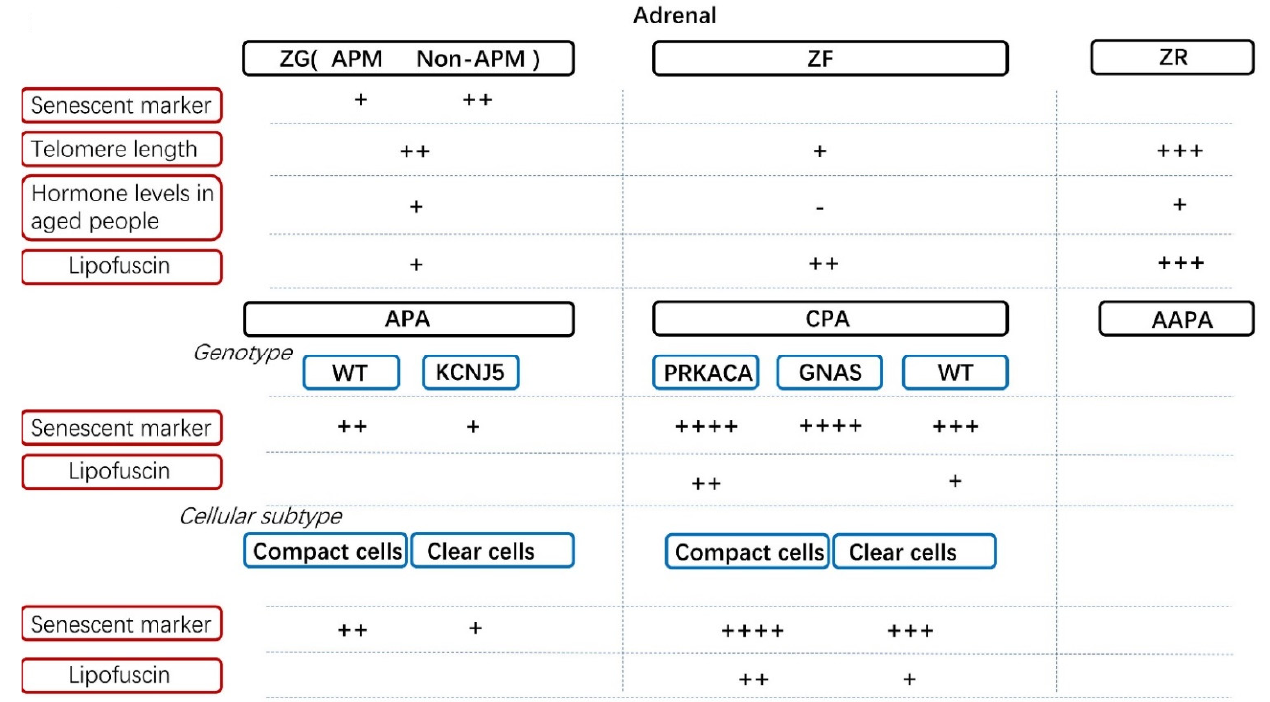
Figure 3. The senescent phenotype in the adrenal cortex. There was no discrepancy of senescent markers including p16 and p21 among ZG, ZF and ZR. However, aldosterone-producing micronodules (APM) harbored more abundant senescent markers than non-APM cells of ZG. The telomere length increased in the order of the ZF, ZG and ZR, whereas the lipofuscin accumulation increased in the order of the ZG, ZF and ZR. In aged people, aldosterone and adrenal androgen were reported to elevate in contrast to the decline of cortisol level. In adrenocortical disorders, CPAs were reported to harbor more abundant senescent markers than APAs, especially in PRKACA and GNAS -mutated ones. In addition, lipofuscin was more abundant in PRKACA -mutated CPA than wild types. Based on cellular morphology, senescent markers and lipofuscin were more abundant in compact cells than clear cells, especially in CPAs than in APAs which has not been investigated in adrenal androgen-producing adenoma (AAPA).